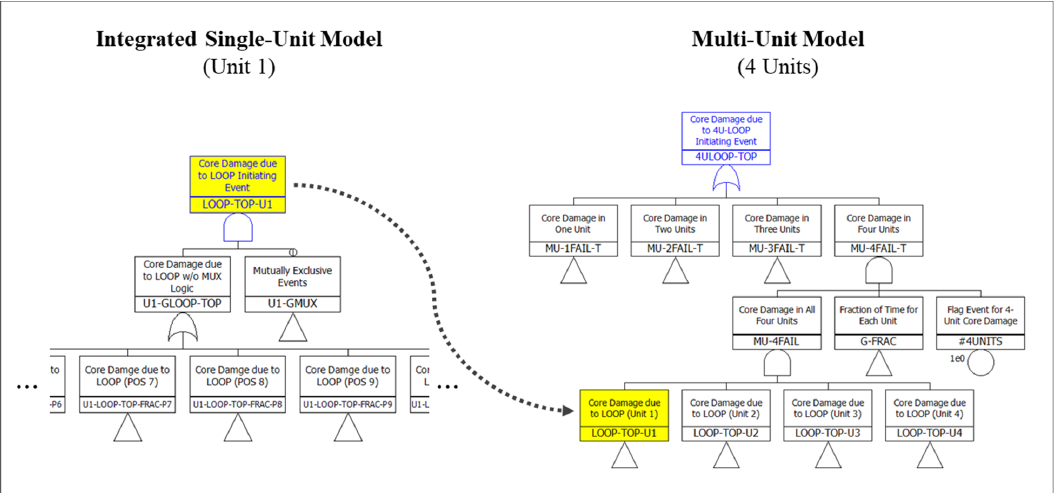
Figure 5. Example multi-unit model combining integrated single-unit models (4-unit case).